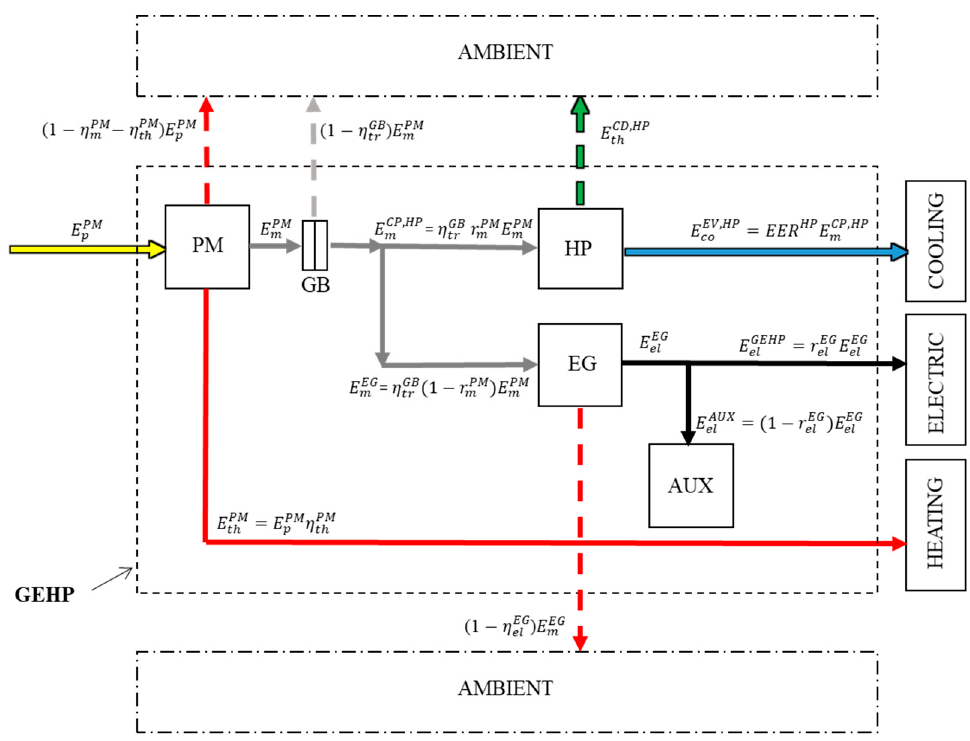
Figure 14. GEHP including an EG in cooling operating